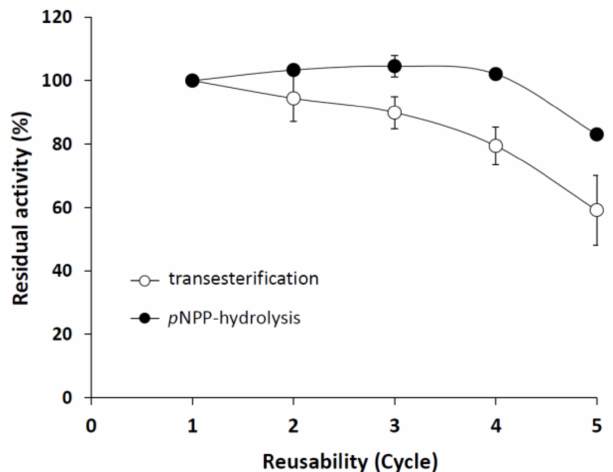
Figure 7. Operational stability of immobilized M. echinosphaera CBS 575.75 lipase during p NPP hydrolysis and transesterification reactions. Reaction conditions of the p NPP-hydrolyzing